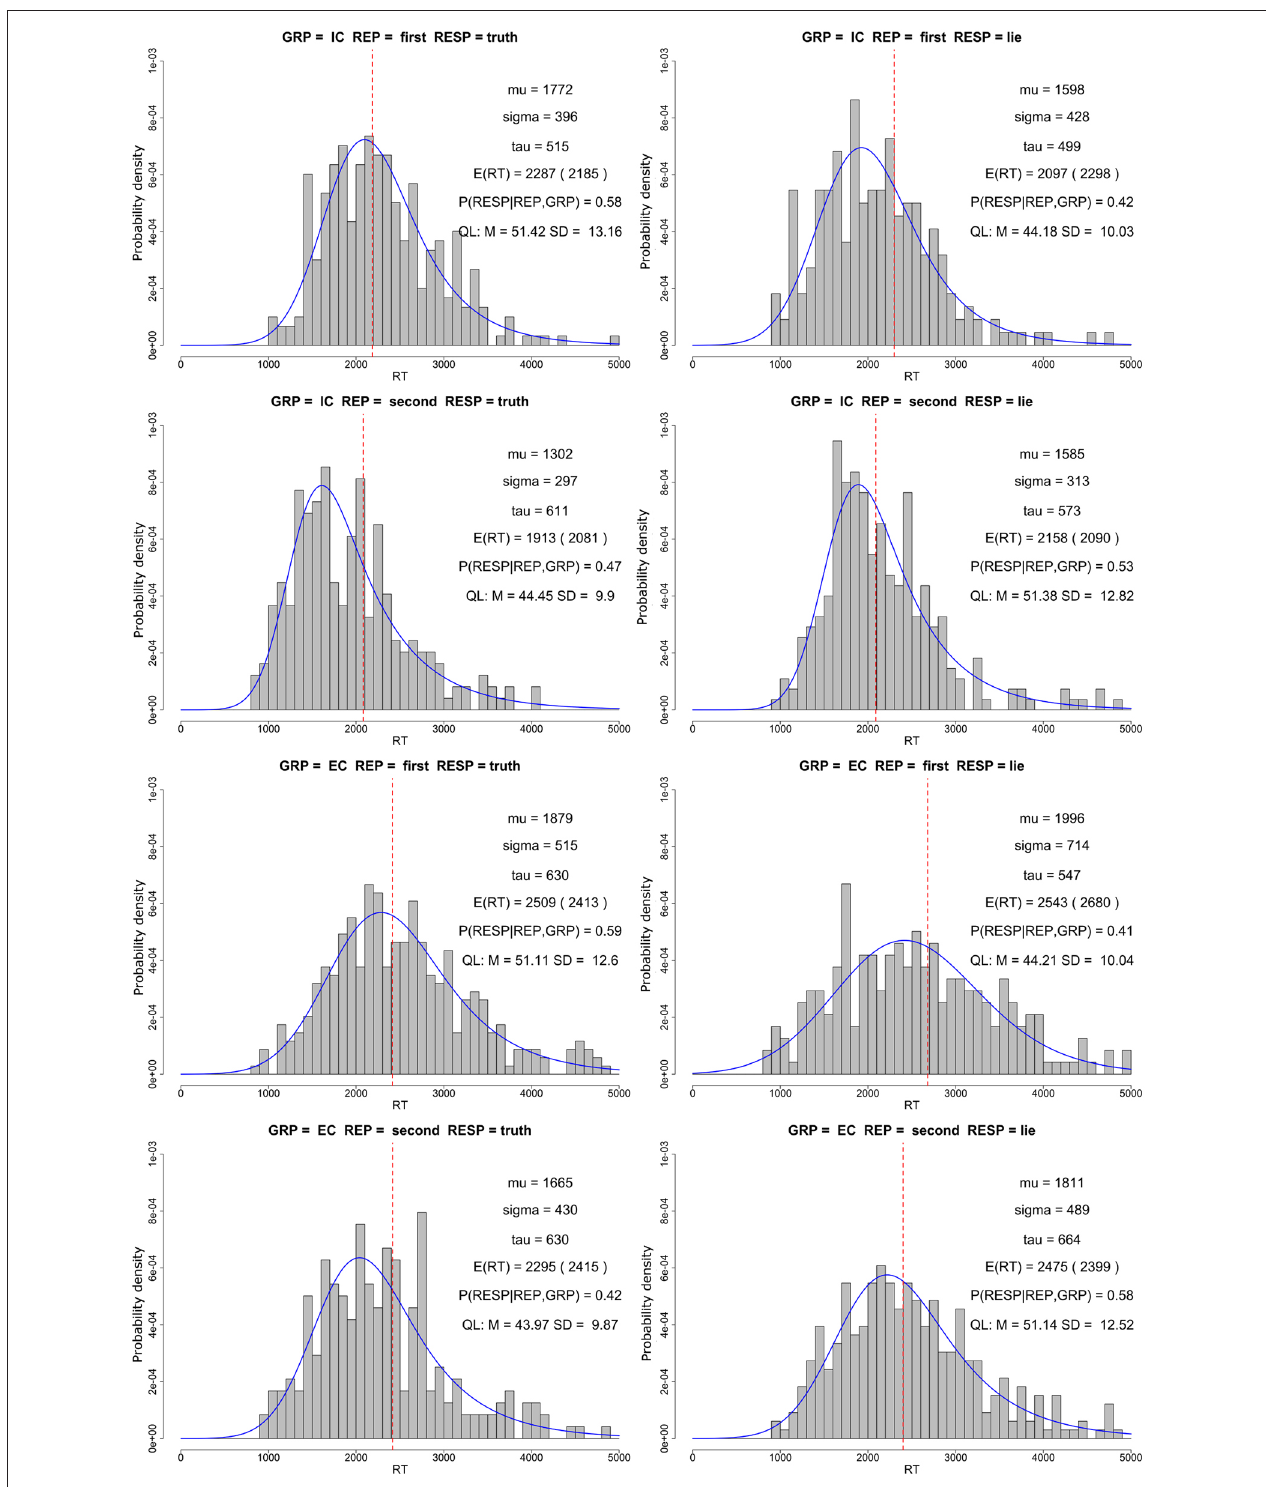
FIGURE 2 | The histograms represent raw RTs for each group, repetition and response type. Mu, sigma, and tau values represent parameters of the Gaussian-exponential distribution fit to the raw data (blue line). E(RT) denotes expected value of raw data (mu + tau), and the value in the parentheses represents the expected value based on fixed effects of the statistical model (red vertical line). P(RESP|REP,GRP) denotes the probability of the response presented in each histogram given the repetition and group it belongs to. QL denotes mean (M) and standard deviation (SD) of average question length (number of characters) for the respective